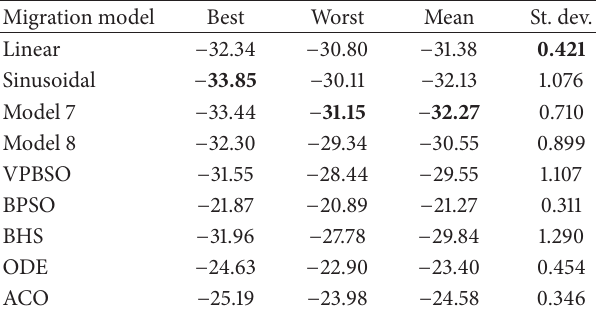
Table 7: Comparativeresultsfor1000-element planar thinnedarray. The smaller values are in